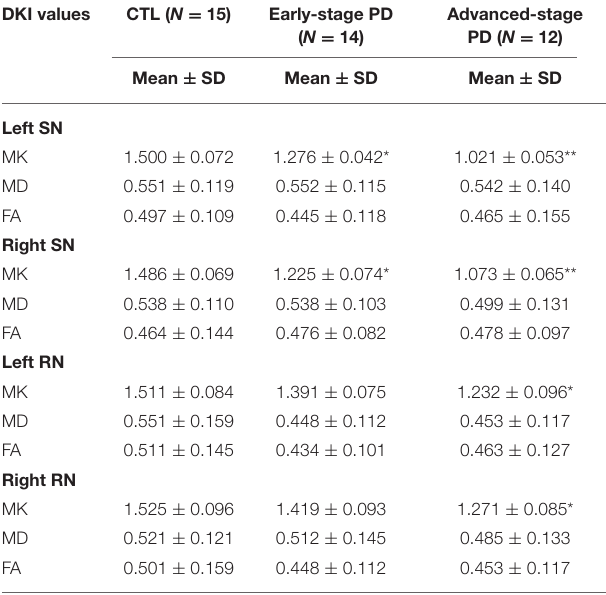
TABLE 1 | Diffusion kurtosis imaging values in the bilateral red nucleus and substantia nigra in the Parkinson’s disease and control groups. DKI values